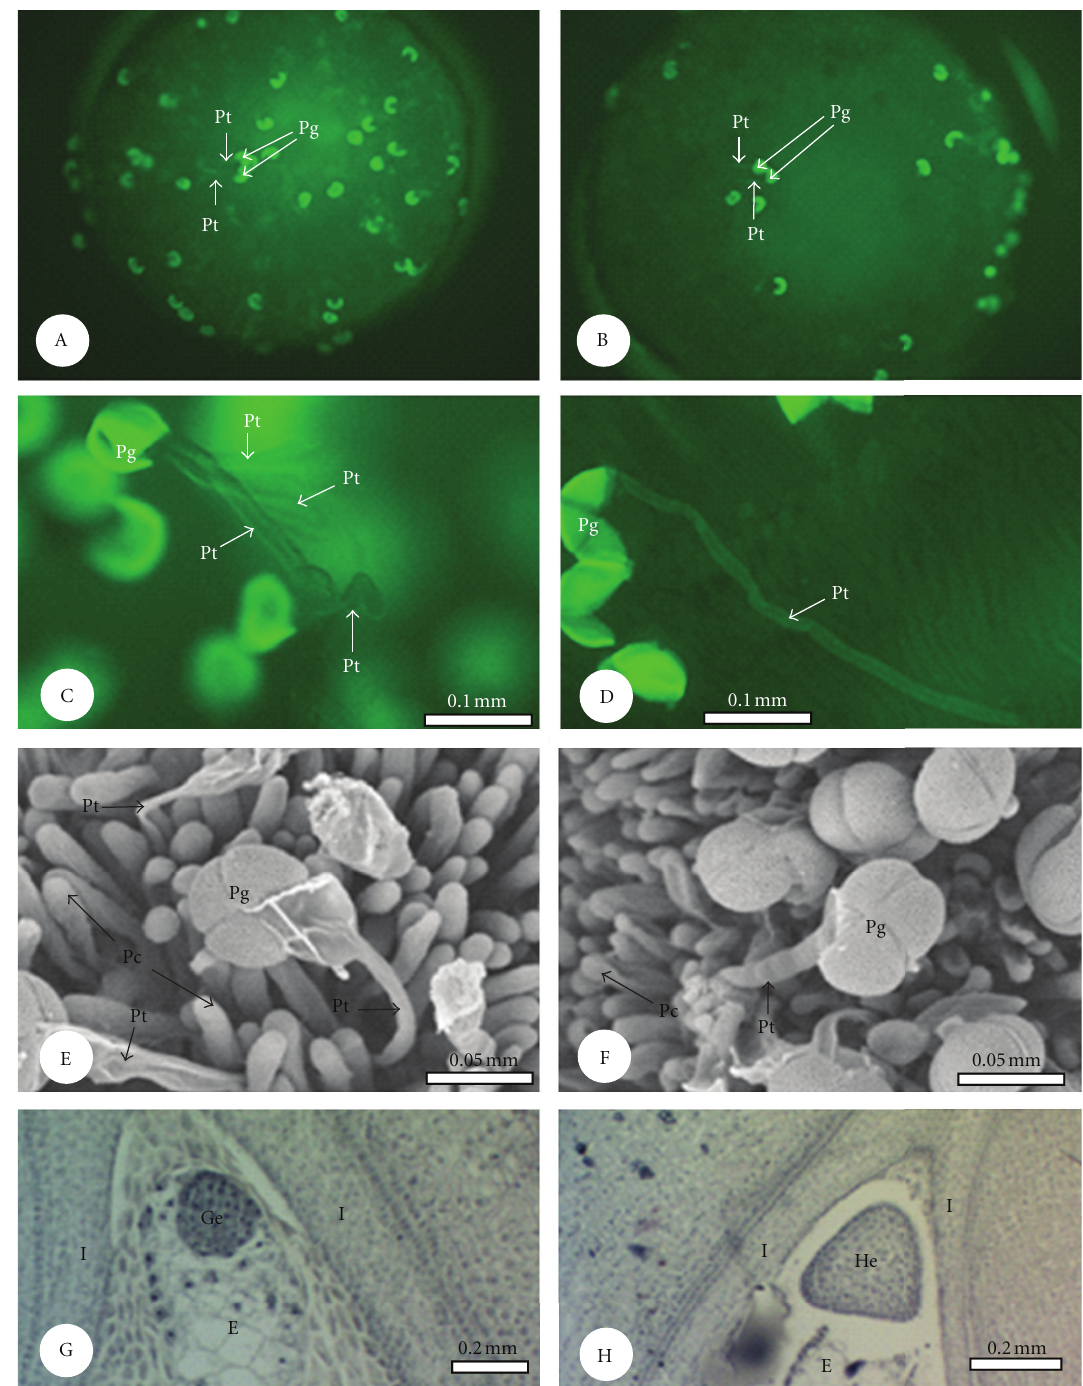
Figure 2: Pollen grains and pollen tubes on stigmas at 4h after pollination and anatomical structure of young embryos. (A): Many pollen grains germinated on stigmas in “Jinsenianhua” × “Qinhuaihuadeng”. (B): A few pollen grains germinated on stigmas in “Qin- huaihuadeng” × “Jinsenianhua”. (C and D): Some abnormal pollen tubes in “Qinhuaihuadeng” × “Jinsenianhua”. (E): SEM micrograph of an abnormal pollen tube in “Qinhuaihuadeng” × “Jinsenianhua”. (F): SEM micrograph of a normal pollen tube in “Jinsenianhua” × “Qinhuaihuadeng”. (G): A normal globular embryo at 1d after artificial pollination. (H): A normal heart embryo at 2d after artificial pollination. Abbreviations: E (endosperm), Ge (globular embryo), He (heart embryo), I (integument), Pc (papilla cell), Pg (pollen grain), and Pt (pollen